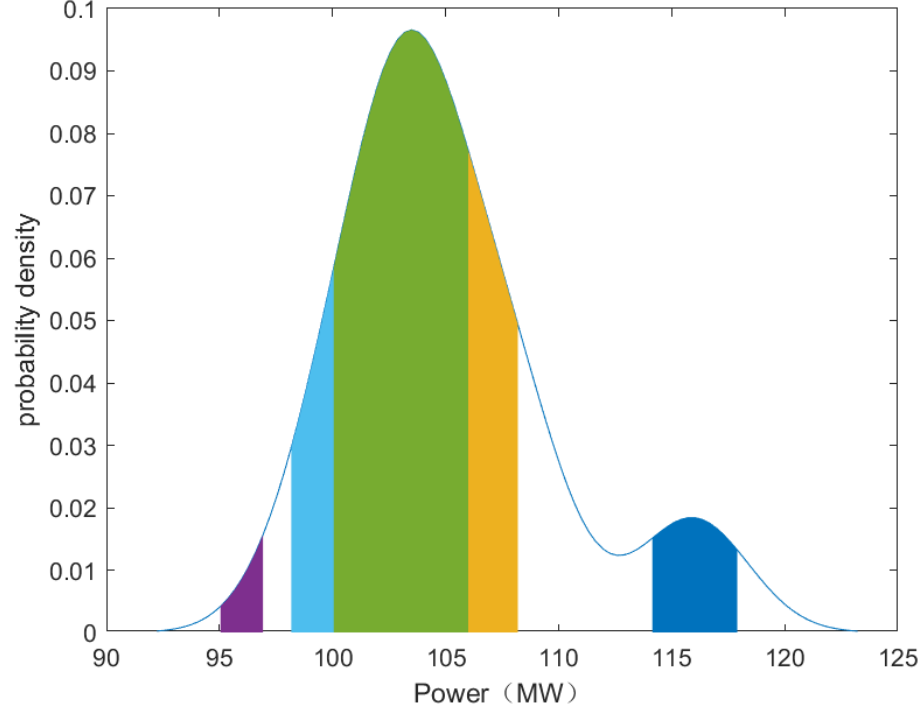
Figure 8. Wind-power output probability interval division. Table 2. Wind-power output value and corresponding probability.